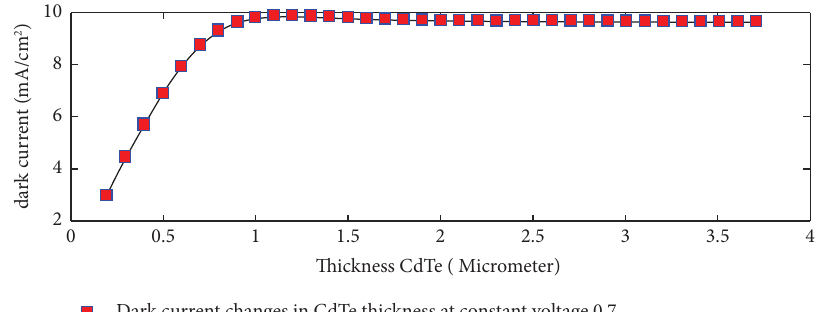
Figure 17: Dark current in terms of the thickness of the absorber layer at a constant voltage of